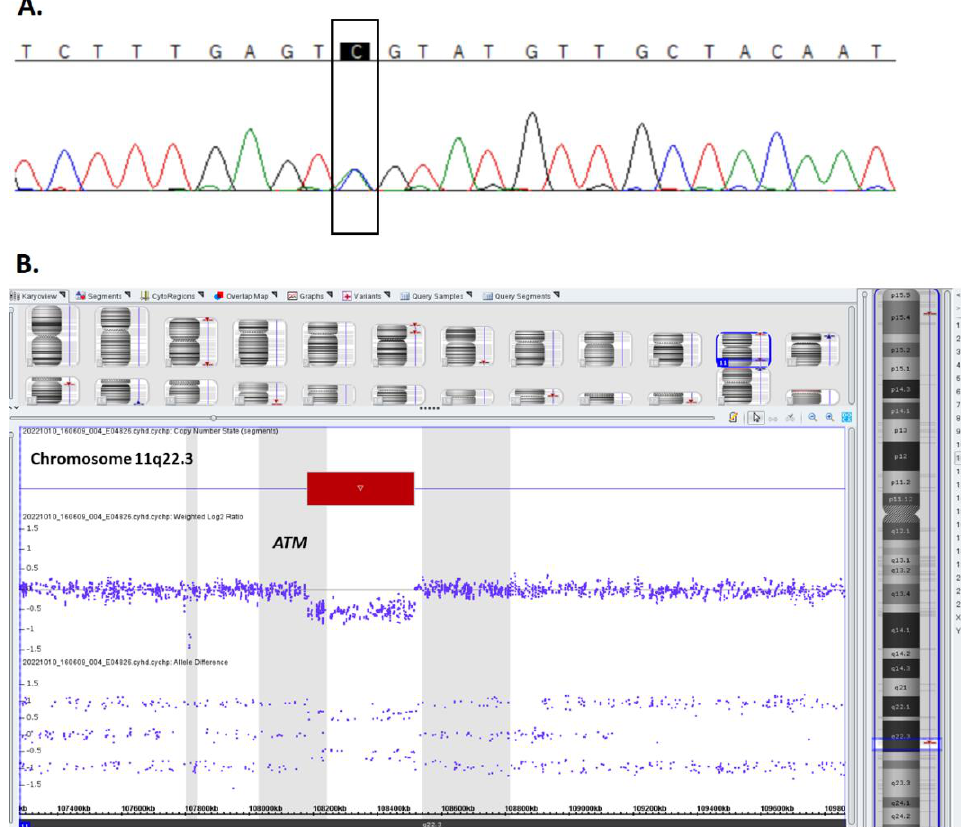
Figure 1. Pathogenic constitutional variants identified in the ATM gene in the proband. ( A ) Chro- matogram displaying heterozygous missense mutation (NM_000051.3):c.434T>G within the ATM gene sequence (characteristic of the pathogenic sequence variant in Table S1). The electropherogram indicates the sequence of the anti-sense strand. ( B ) Chromosome microarray (CMA) data plot for chromosome 11 showing the germline monoallelic deletion of 11q22.3 encompassing exons 42–66 of the ATM gene. Deviations of probe Log2 ratios below 0 of the SNP probes on chromosome 11q22.3 cytoband indicate interstitial microdeletion identified in the genomic profile of the patient. The coordinates are in